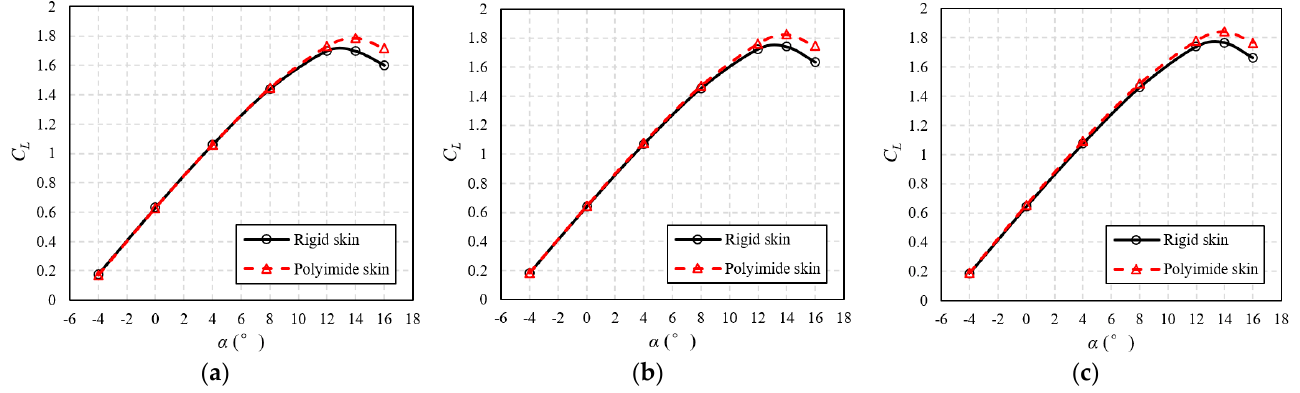
( b ) Figure 21. Membrane deformation calculated by finite element method: ( a ) Upper surface; ( b ) Lower surface. 5. Numerical Analysis 5.1. Stall Performance Because the stall performance of the wing cannot be obtained directly by experimental means, the relevant research can bce performed with the help of the numerical simulation method established in Chapter 4. As portrayed in Figure 22, under the three incoming velocities, when α is in the range of − 4°~8°, the lift coe ffi cient curves of the two wings have a high degree of coincidence, indicating that the membrane deformation does not affect the lift characteristics at medium and small angles of attack, which is consistent with the wind tunnel experiment results. When α > 8°, the two lift